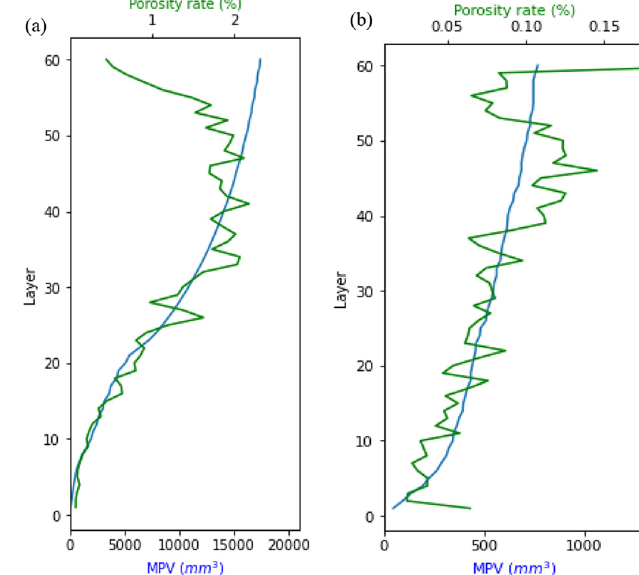
Fig. 10. Mean melt pool volume (MPV) and porosity rate evolutions according to layer number: (a) idle time=2 s; (b) idle time